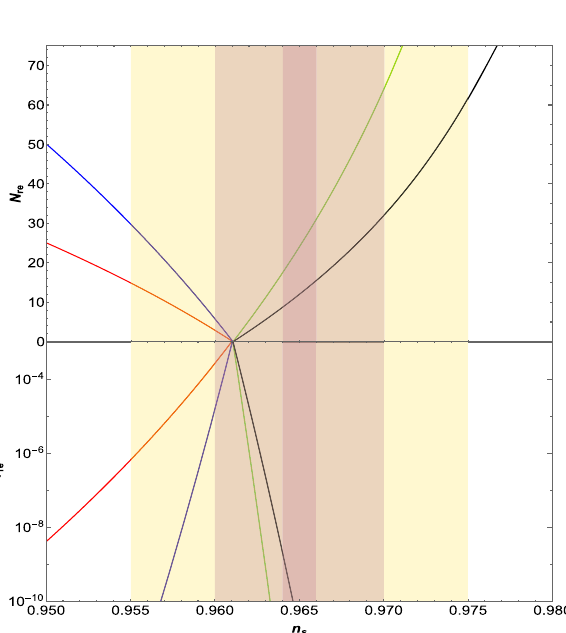
= 0, the green line re